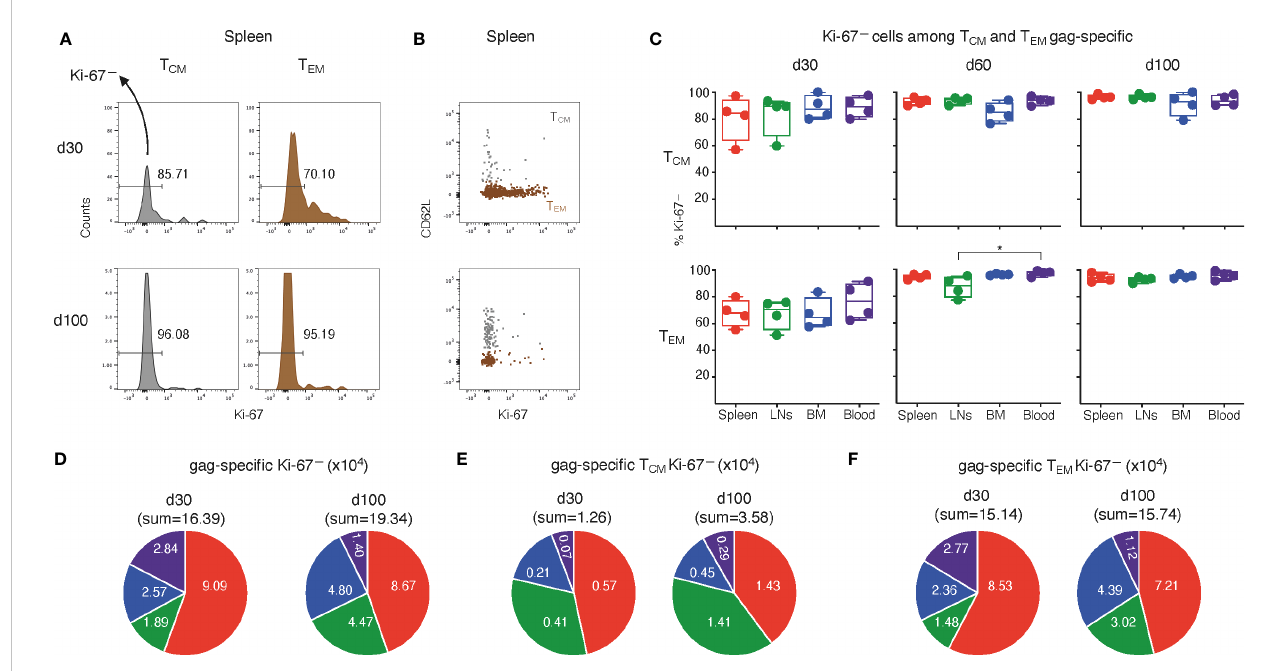
FIGURE 3 Analysis of Ki-67 — cells among T CM and T EM -gag-speci fi c CD8 T cells from ChAd-gag-primed mice, and estimation of absolute cell numbers. Spleen, LN, BM and blood cells from primed mice represented in Figure 2 were analyzed for Ki-67 expression by TCM and TEM gag-speci fi c CD8 T cells, gated as in Figure 2. (A – C) . Typical histograms showing the percentage of Ki-67 — cells among TCM (left) and TEM (right) cells (A) , and examples of Ki-67/CD62L plot showing an overlay of TCM (gray) and TEM cells (brown) (B) ; both panels represent spleen gag-speci fi c CD8 T cells from primed mice at d30 (top) and d100 (bottom). Summary of results of Ki-67 — cells among TCM (top) and TEM (bottom) gag-speci fi c CD8 T cells from spleen, LNs, BM and blood at d30, d60 and d100 (C) . In A , numbers represent percentages of cells in the indicated regions. (D – F) . Absolute numbers of gag-speci fi c Ki-67 — CD8 T cells (D) , and of TCM (E) and TEM (F) Ki-67 — gag-speci fi c CD8 T cells at d30 and d100 in spleen, LNs, BM and blood. Statistical analysis was performed by Friedman test with Dunn ’ s correction for multiple comparison (C) . Statistically signi fi cant differences are indicated (* P ≤